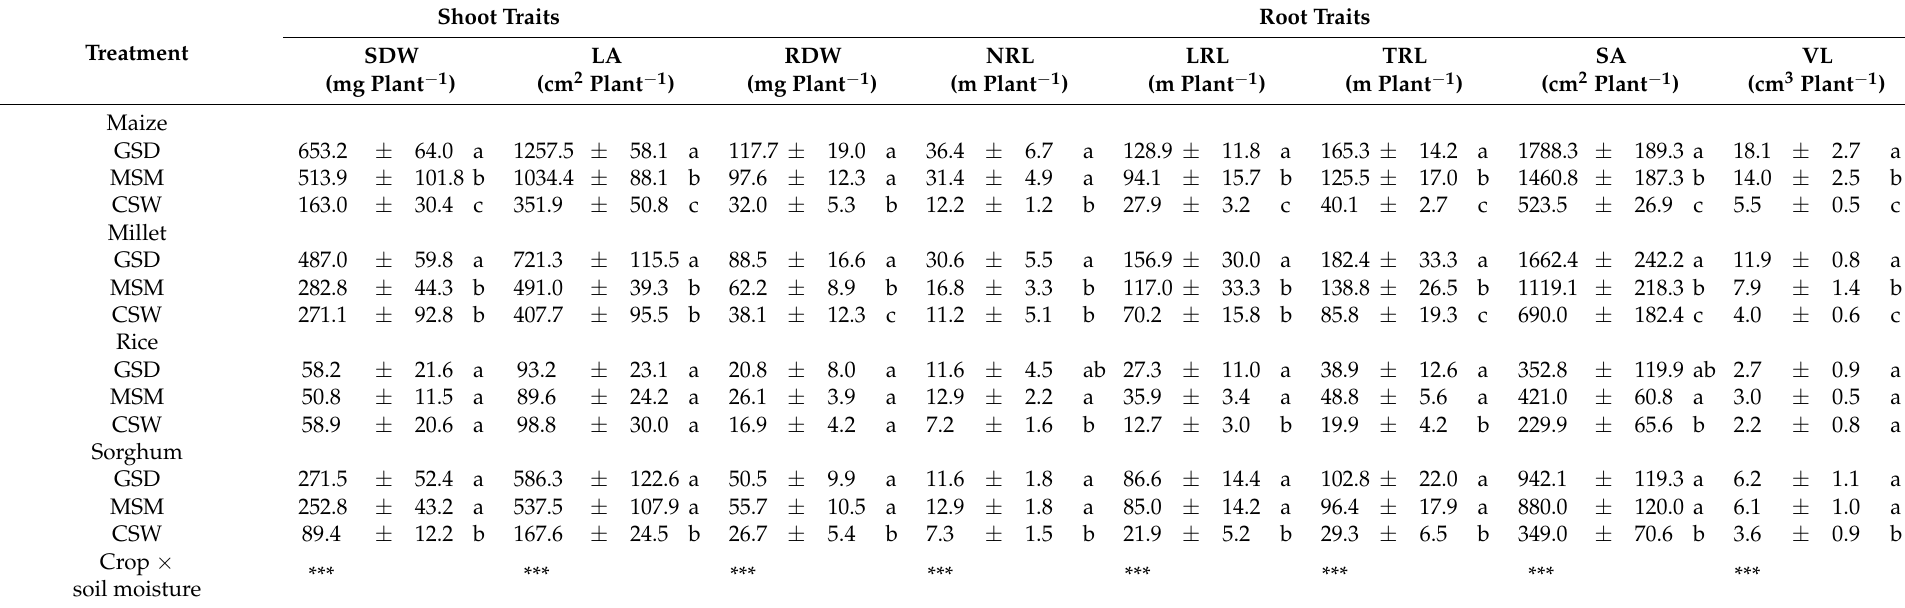
Table 1. Average of shoot dry weight (SDW), leaf area (LA), root dry weight (RDW), nodal root length (NRL), lateral root length (LRL), total root length (TRL), surface area (SA), and volume (VL) across gradual soil drying (GSD), moderate soil moisture (MSM), and continuous soil waterlogging (CSW) at 25 days after treatment.